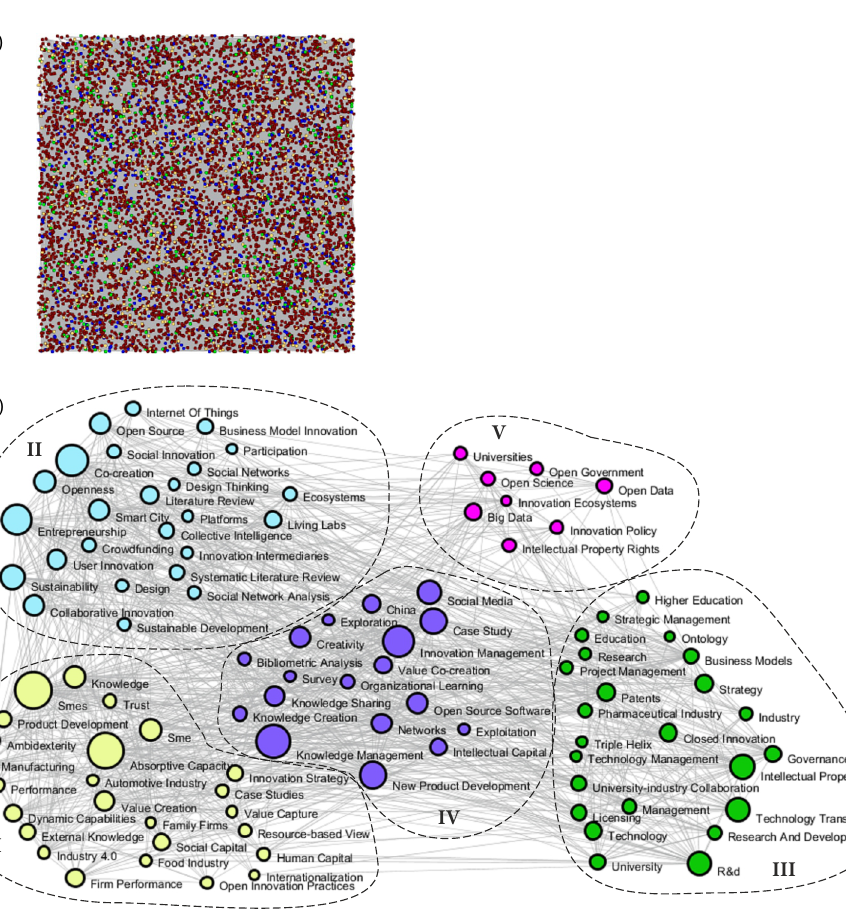
Figure 7. Keyword clustering results: a – The cluster of all keywords; b – Clustering results based on Top 100